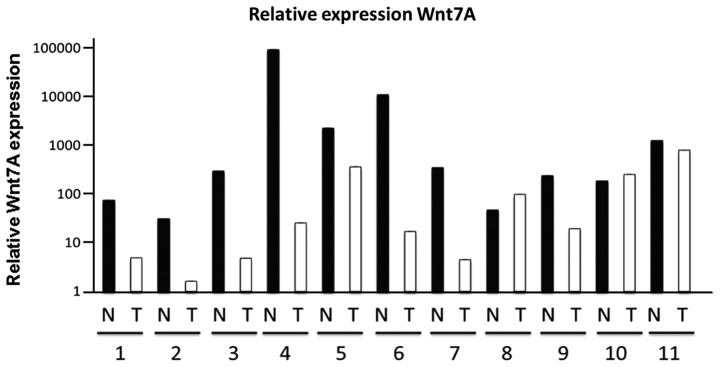
Wnt7A expression differed significantly between the 11 paired normal (N) and tumor tissues (T).